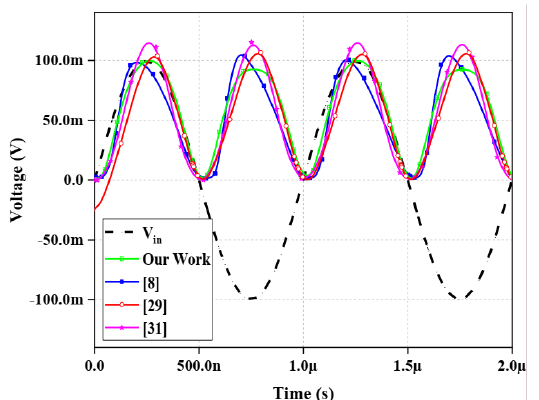
Figure 15. Comparison of simulation results obtained for [8,29,31] with presented rectifier design at frequency 1 MHz and V in = 100